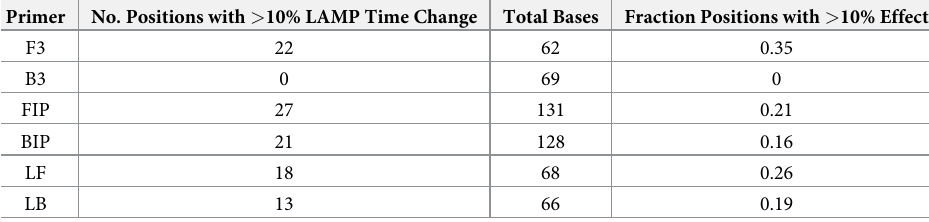
Table 2. The effect of single point mutations on RT-LAMP